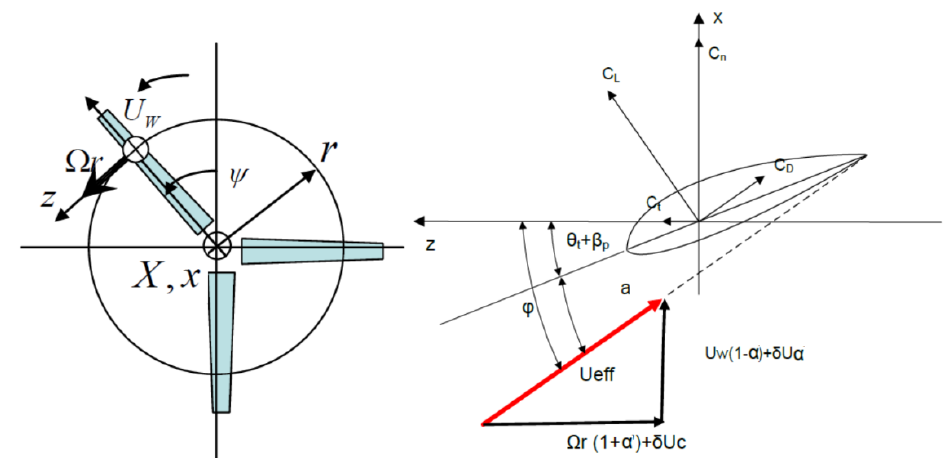
Figure 5. Definition of the aerodynamic set-up.